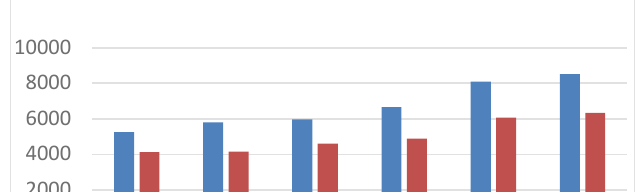
Market Share Name of Authorities